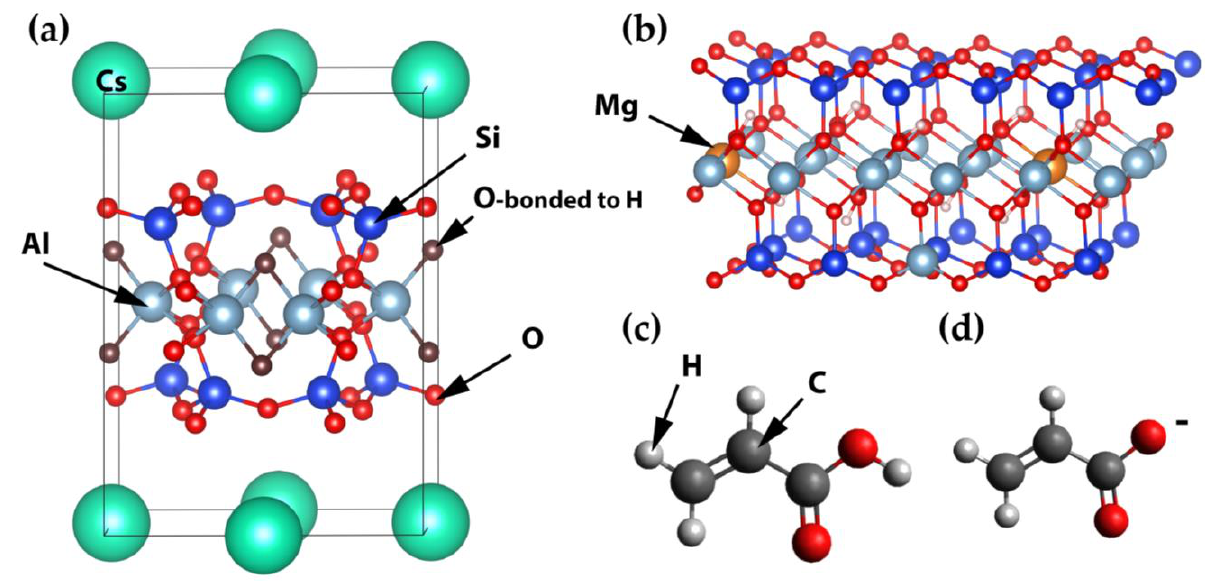
Figure 2. ( a ) Unit call of montmorillonite structure reported in [17], ( b ) a small fragment of initial (before simulations) montmorillonite layer built on the base of the unit call presented in ( a ), ( c ) acrylic acid molecule, and ( d ) acrylic anion based on structured data from [18].